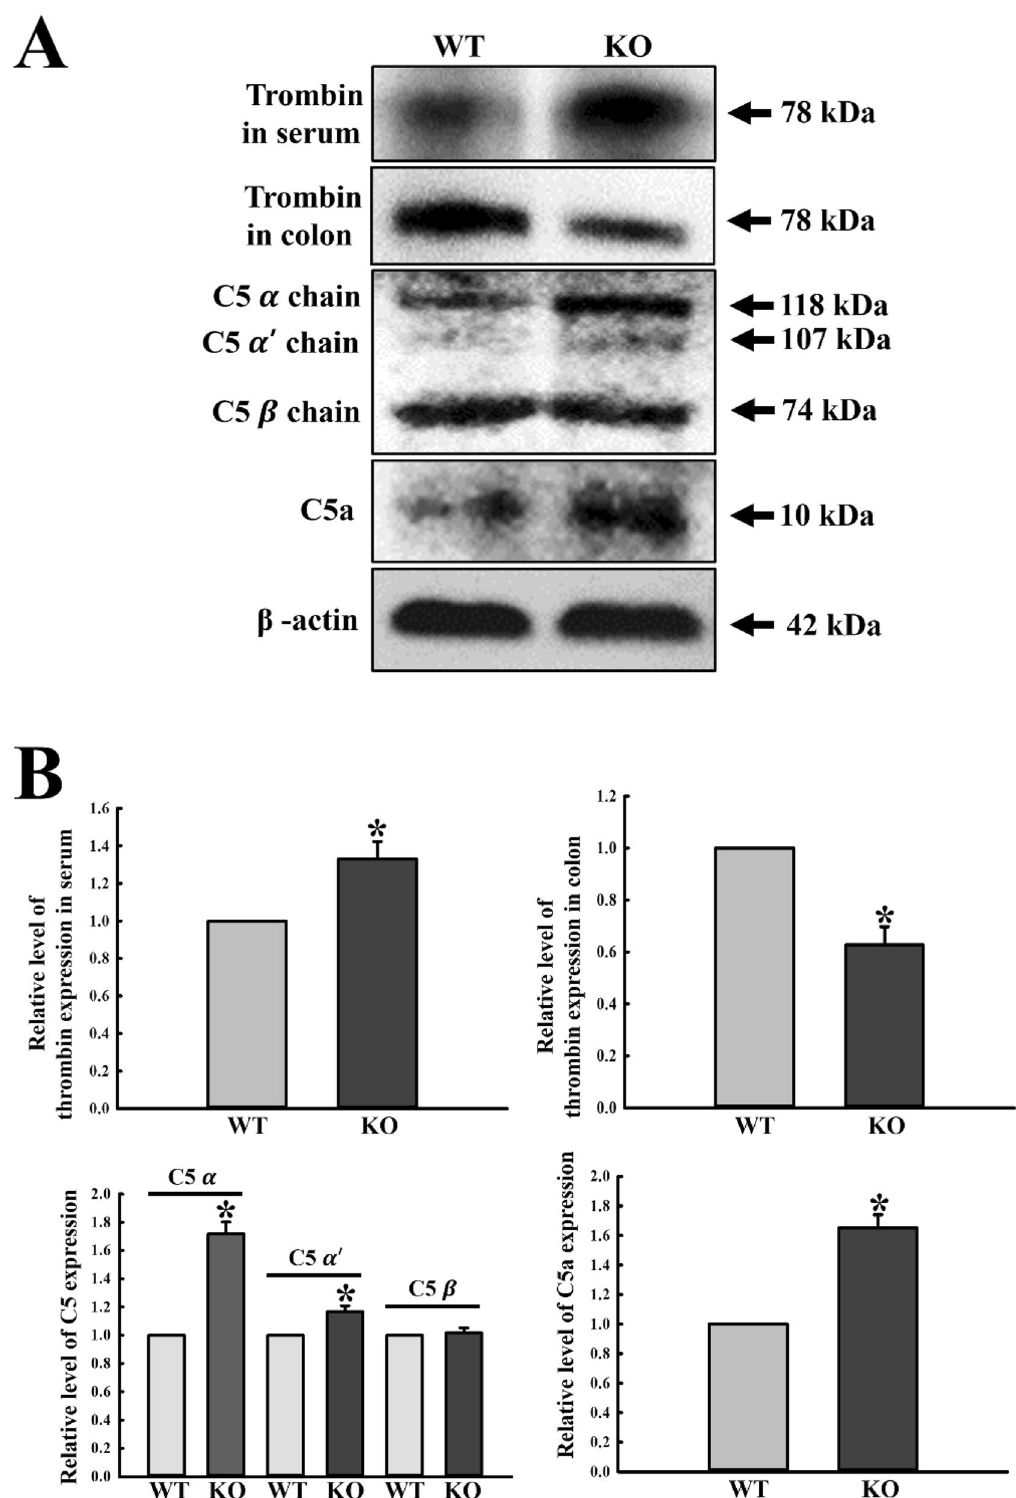
Figure 7. Levels of C5 and its mediated inflammatory regulators. ( A ) Expression levels of thrombin and C5 proteins were determined by Western blot analysis using specific primary antibody and HRP-labeled anti-rabbit IgG antibody. ( B ) Band intensities were determined using an imaging densitometer, and protein expressions were calculated relative to the intensity of β-actin. Tissue samples were collected from 3 to 5 mice per group, and each lysate was analyzed in duplicate for Western blot (final n = 6–10). Data are reported as the mean ± SD. * indicates p < 0.05 compared to the WT